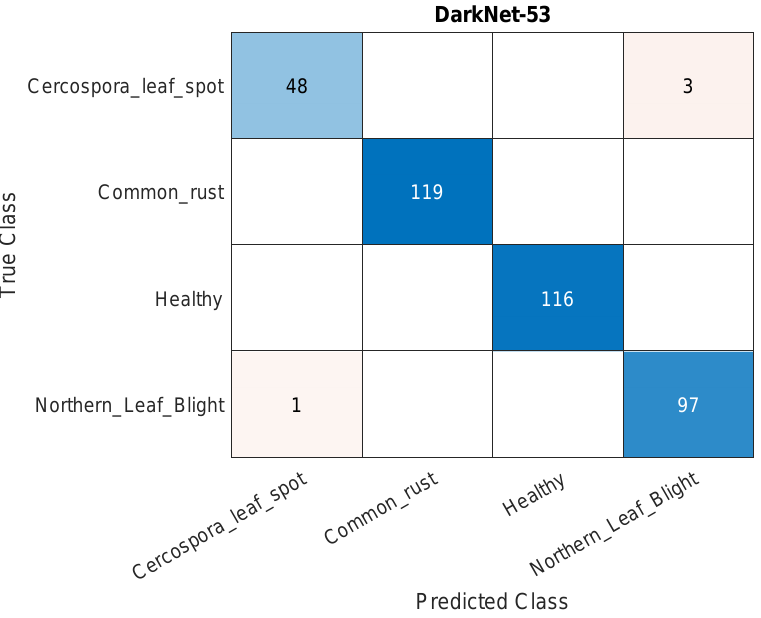
Figure 6. A sample confusion matrix for the DarkNet-53 model and using 90% of the data for